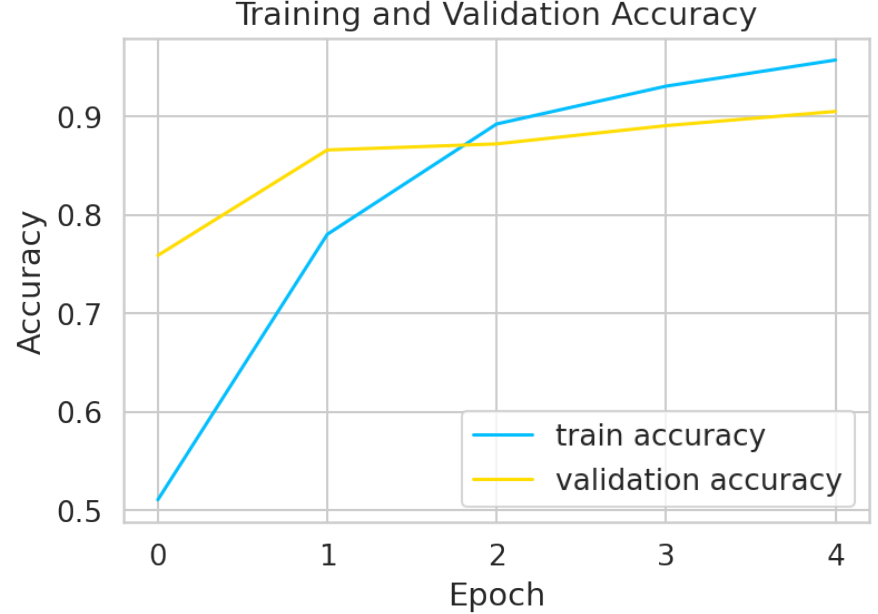
Figure 15. Training and validation accuracy for RoBERTa.